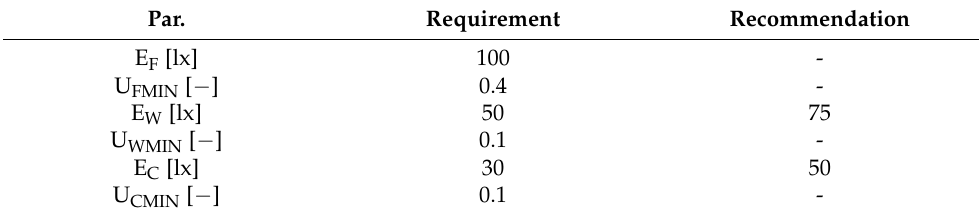
Table 1. Requirements and recommendations for lighting of the corridor planes. Par. Requirement